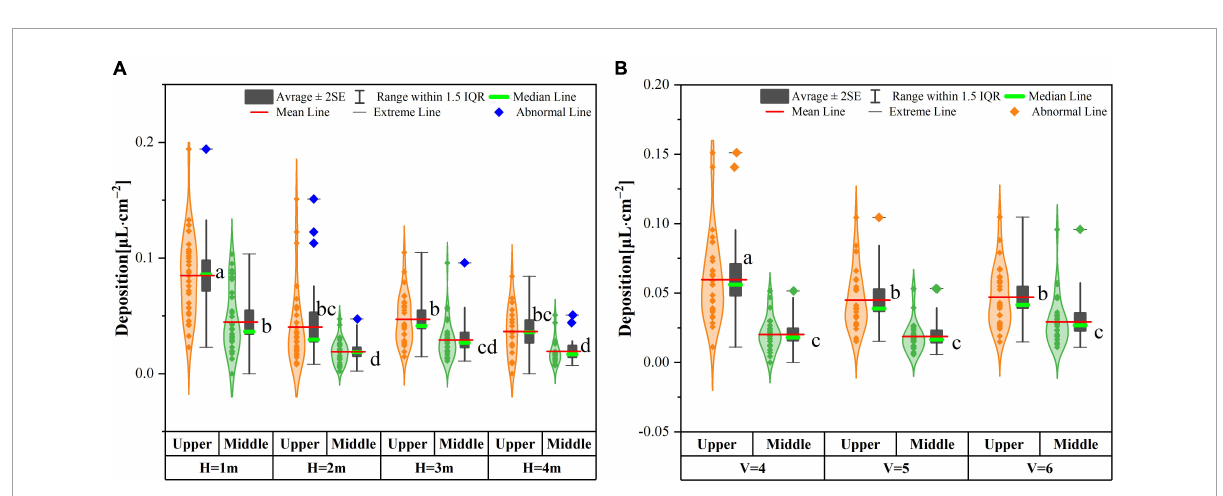
FIGURE11 Distribution characteristics of droplet deposition in the rice canopy. (A) Represents deposition distribution affected by flight heights, (B) Represents deposition distribution at affected by flight speeds. Where “H” represents the mUAV flight height, “V” represents the mUAV flight speed, “Upper” represents the upper rice layer, and “Middle” represents the middle rice layer. a, b, c, and d indicate a significant difference at P <